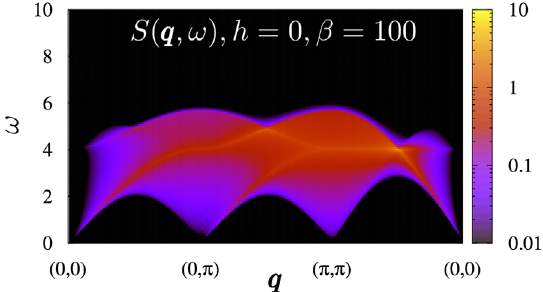
FIG. 2. Dynamical spin structure factor at h ¼ 0 . At the considered temperature, we can safely neglect the thermal fluctuations of the Ising fields. Only Ising field configurations with a π flux per plaquette